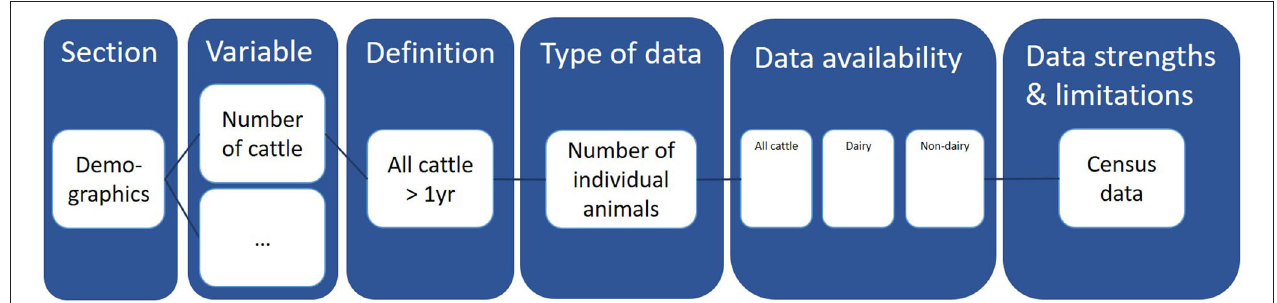
FIGURE 2 | Column headings of the initial Microsoft Excel data collection tool developed for BVD, including an example for the variable “Number of cattle” within the section “Demographics.” The first four columns (section, variable, definition, type of data) are given. Column five “data availability” should be answered with yes/no per group of cattle (all cattle, only dairy cattle, only beef cattle) by the user of the tool. Column six (data strengths and limitations) should also be answered by the user of the tool. An example could be census data.